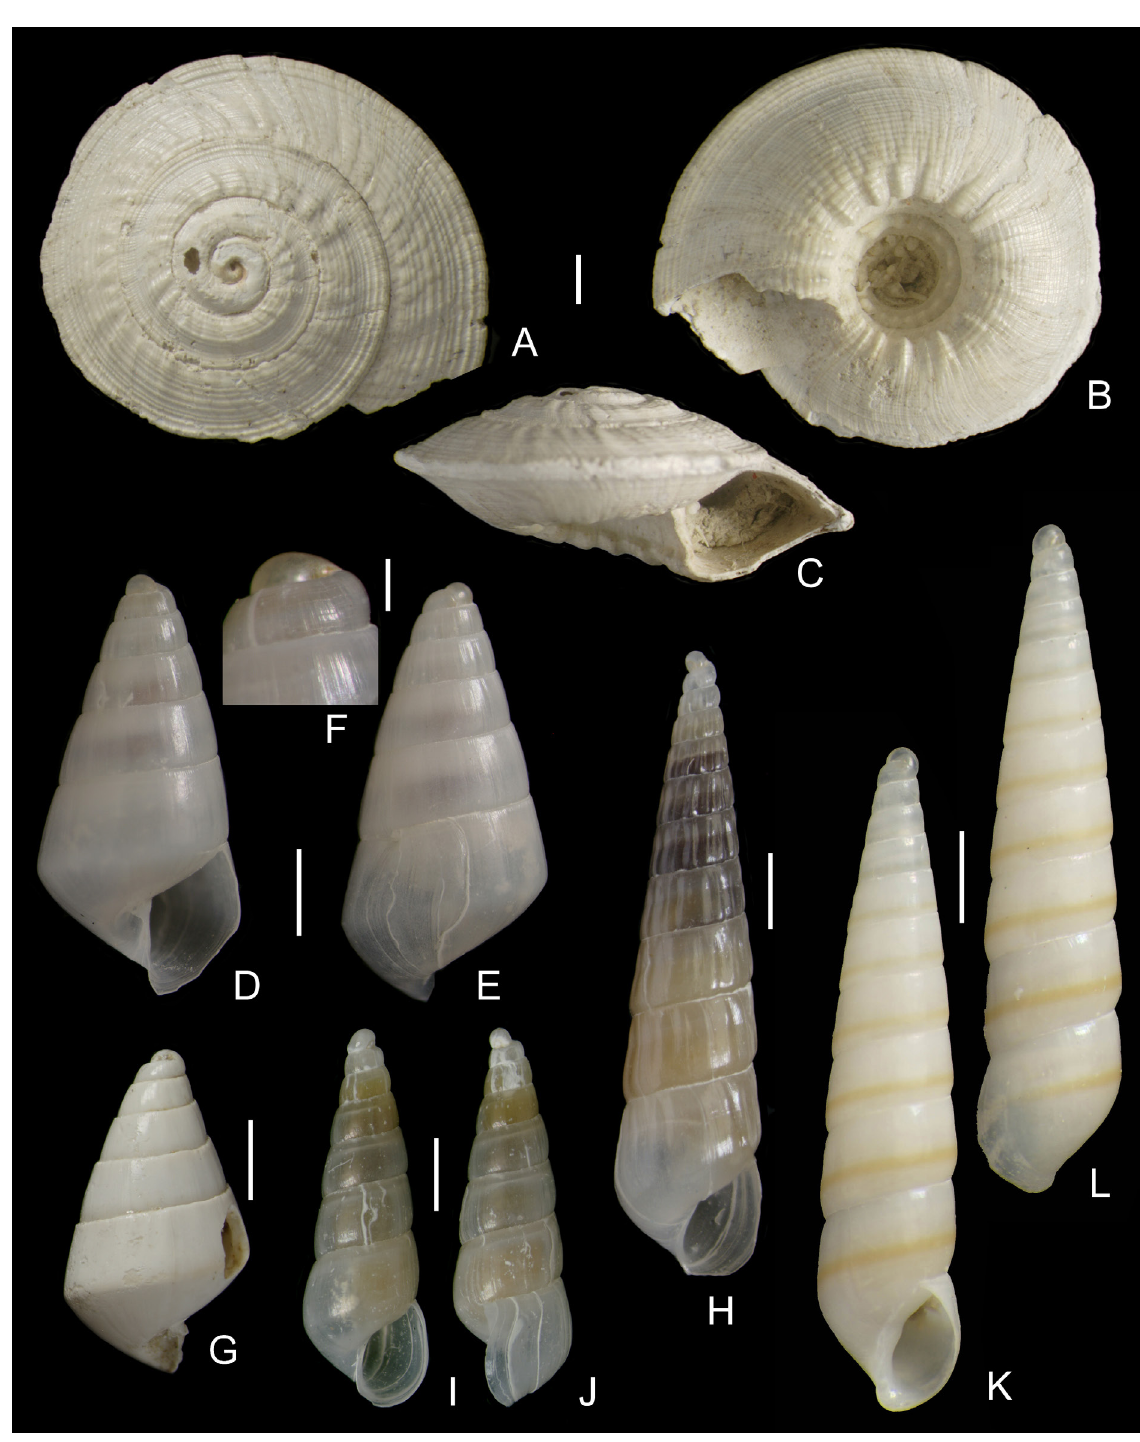
Fig. 28. Heterobranchia 1 (Architectonicidae, Pyramidellidae). A–C . Solatisonax hemisphaerica (Seguenza, 1876), BANGAL 0711, V6, 909 m, 8.9 mm. D–F . Tiberia sp., BANGAL 0711, V10, 1720 m, 4.8 mm. G . Syntype of Pyramidella curtissima Locard, 1897, Travailleur 1881 or 1882, 4.0 mm. H . Turbonilla cf. paucistriata (Jeffreys, 1884), BANGAL 0711, V5, 1631 m, 7.8 mm. I–J . Eulimella sp., BANGAL 0711, V10, 5.3 mm. K–L . Tibersyrnola unifasciata (Forbes, 1844), BANGAL 0711, V6 , 7.2 mm. Scale bars: A–E, G–L = 1 mm; F = 200